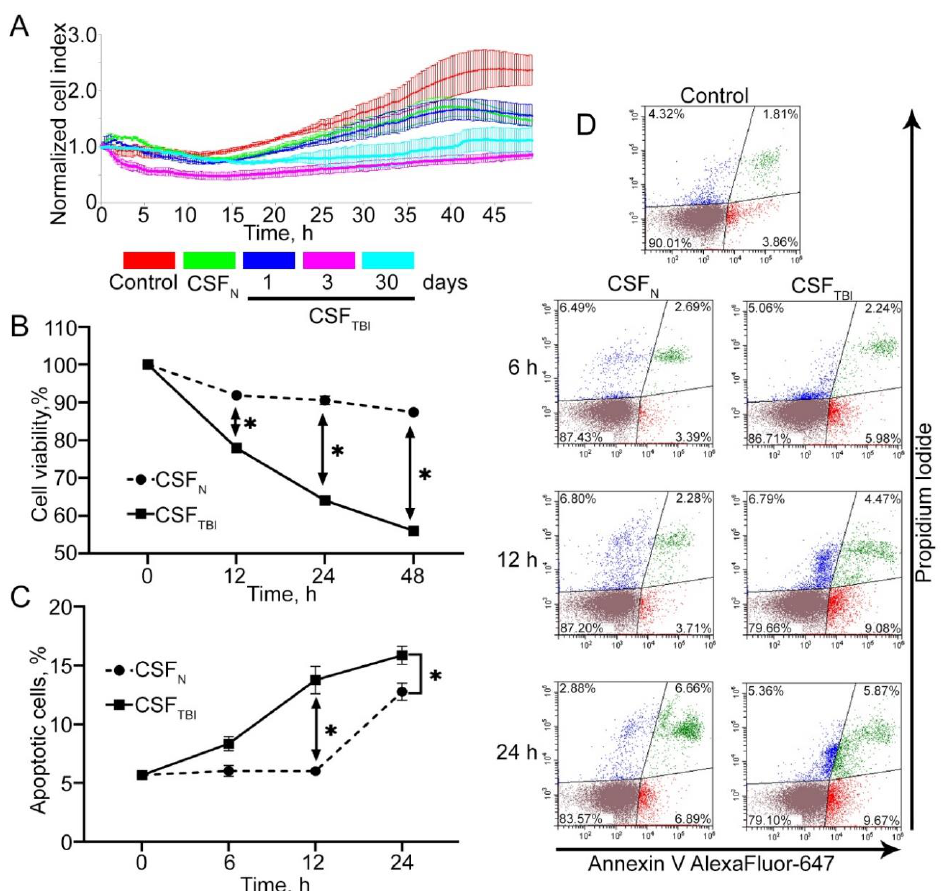
Figure 2. Presentation of an in vitro model for studying secondary damage after traumatic brain injury (TBI). ( A ) Cell index data produced using an xCELLigence device. The graph shows the dynamics of the C6 cellular index placed in a medium containing 30% of rat ’ s cerebrospinal fluid (CSF), received after 1, 3, or 30 days after TBI (CSF TBI ). Control: CSF in medium was replaced by phosphate buffer saline (PBS). CSF N : CSF from non-traumatized rats was used as a negative control. ( B ) Results of analysis with the aid of the 3-(4,5-dimethylthiazol-2-yl)-2,5-diphenyltetrazolium bromide test (MTT). The CSF sample obtained three days after TBI was incubated with C6 cells for 12, 24, and 48 h. ( C ) The results of Annexin V staining. The measurement was provided with the aid of flow cytometry technique. C6 cells were incubated with CSF for 6, 12, or 24 h. ( D ) The distribution of the cell population according to flow cytometry data. Data of three independent experiments presented as mean ± SEM. Statistical significance is indicated as * p <